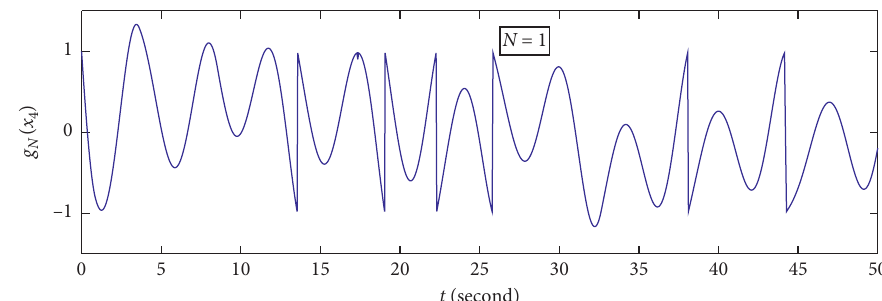
Figure 3: The function curve of g